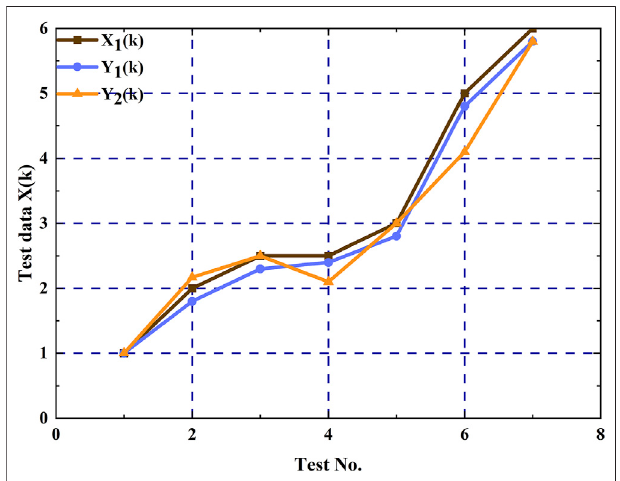
FIGURE 6 | Comparison chart of the variation trend of example